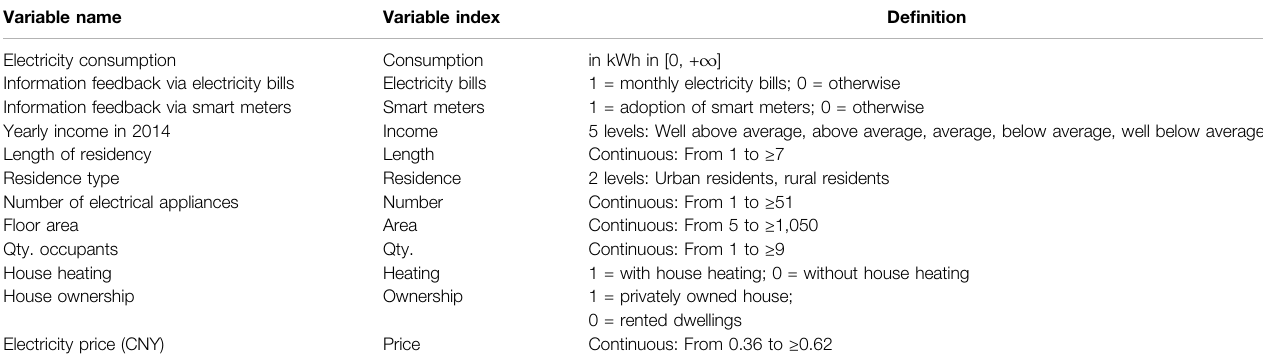
TABLE 1 | Variable de fi nition.